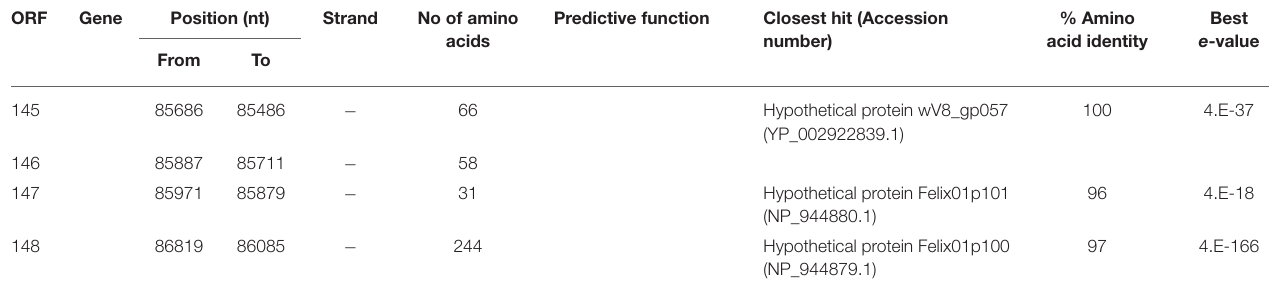
of its proteome with those of E. coli bacteriophages as K1-5 and